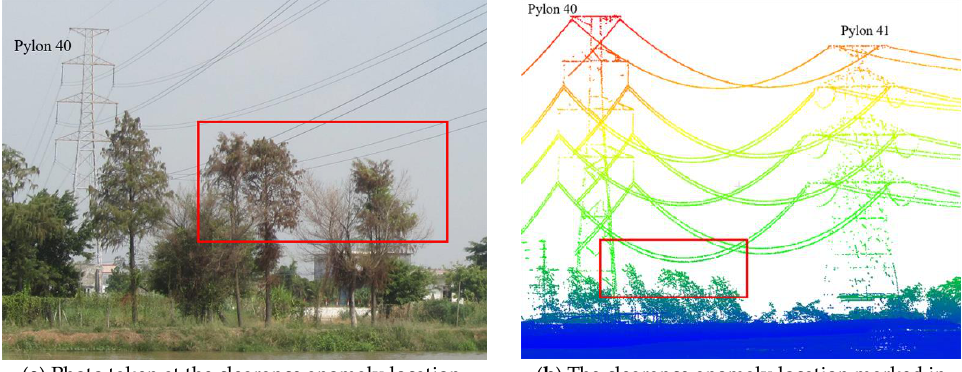
Figure 12. Field verification of the clearance anomaly detection results.